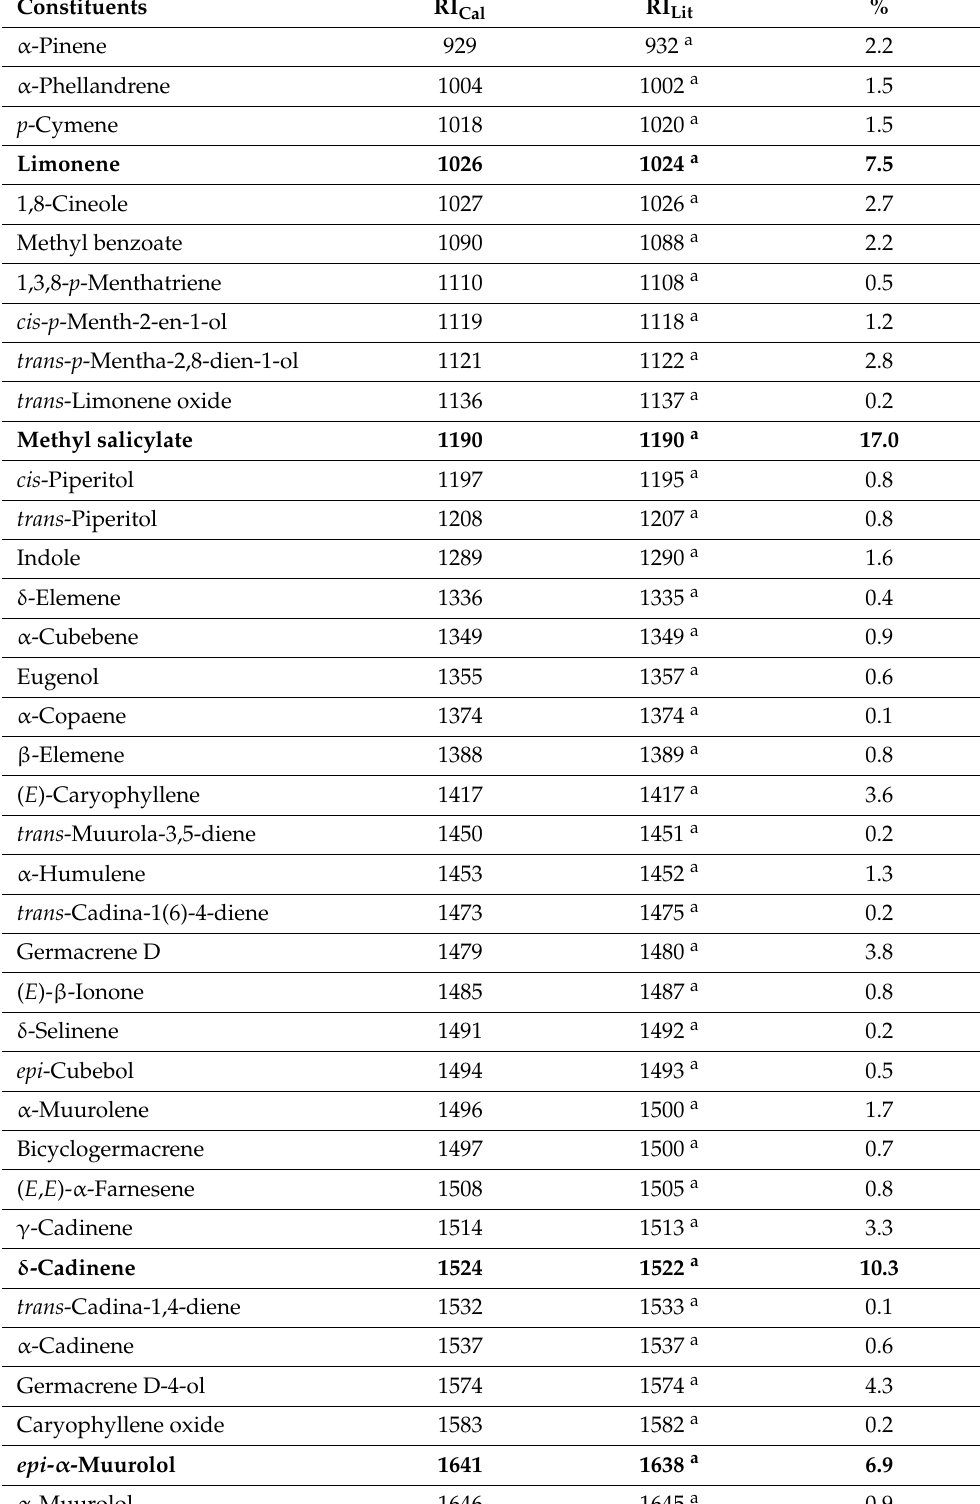
Table 6. Constituents identified in the volatile concentrate of C. gnomus